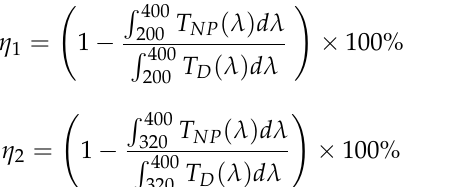
Table 3. UV shielding efficiency of the nanocomposite coatings.